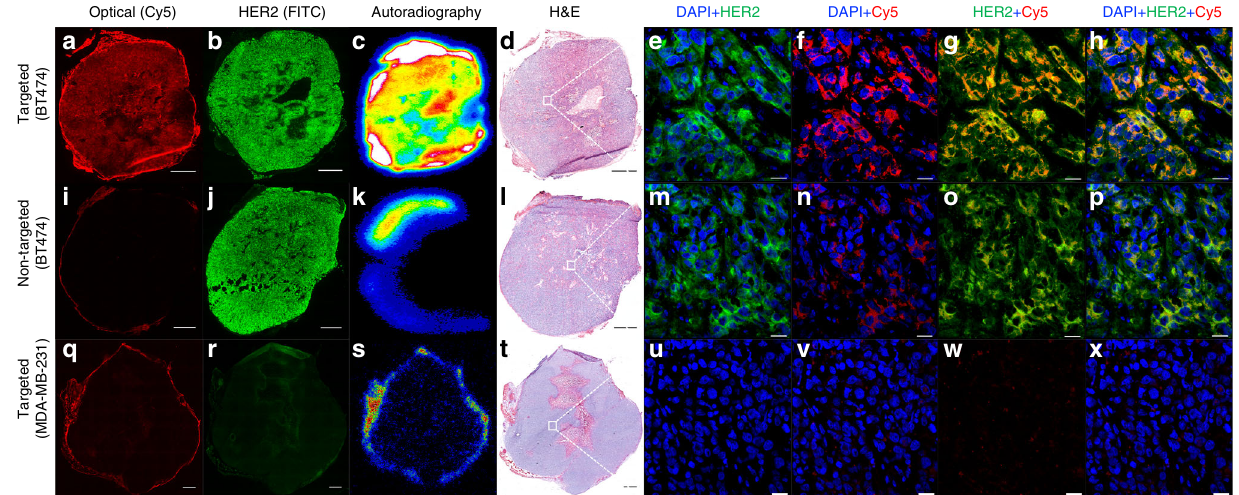
Fig. 5 Correlative ex vivo tumor histopathology. From left to right: Cy5- fl uorescence microscopy (scale bar: 1 mm), HER2 immunohistochemical staining (scale bar: 1 mm), autoradiography, H&E stained tumor tissue specimens (scale bar: 1 mm) harvested 72 h p.i., and confocal microscopy (scale bar: 20 μ m) of random areas (white squares) from corresponding tumor tissue specimens. a – h Targeted group: 89 Zr-DFO-scFv-PEG-Cy5-C ’ dots, BT-474